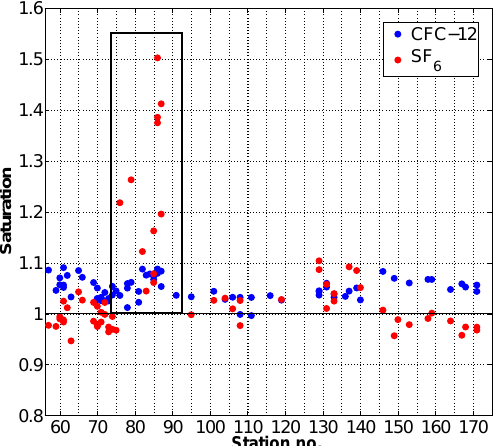
Figure 10. Surface saturation of CFC-12 and SF 6 during the ANT- XXVIII/3 cruise in 2012. SF 6 shows significant supersaturation 1 day after heavy weather conditions with wind speeds between 20 and 25ms − 1 (black